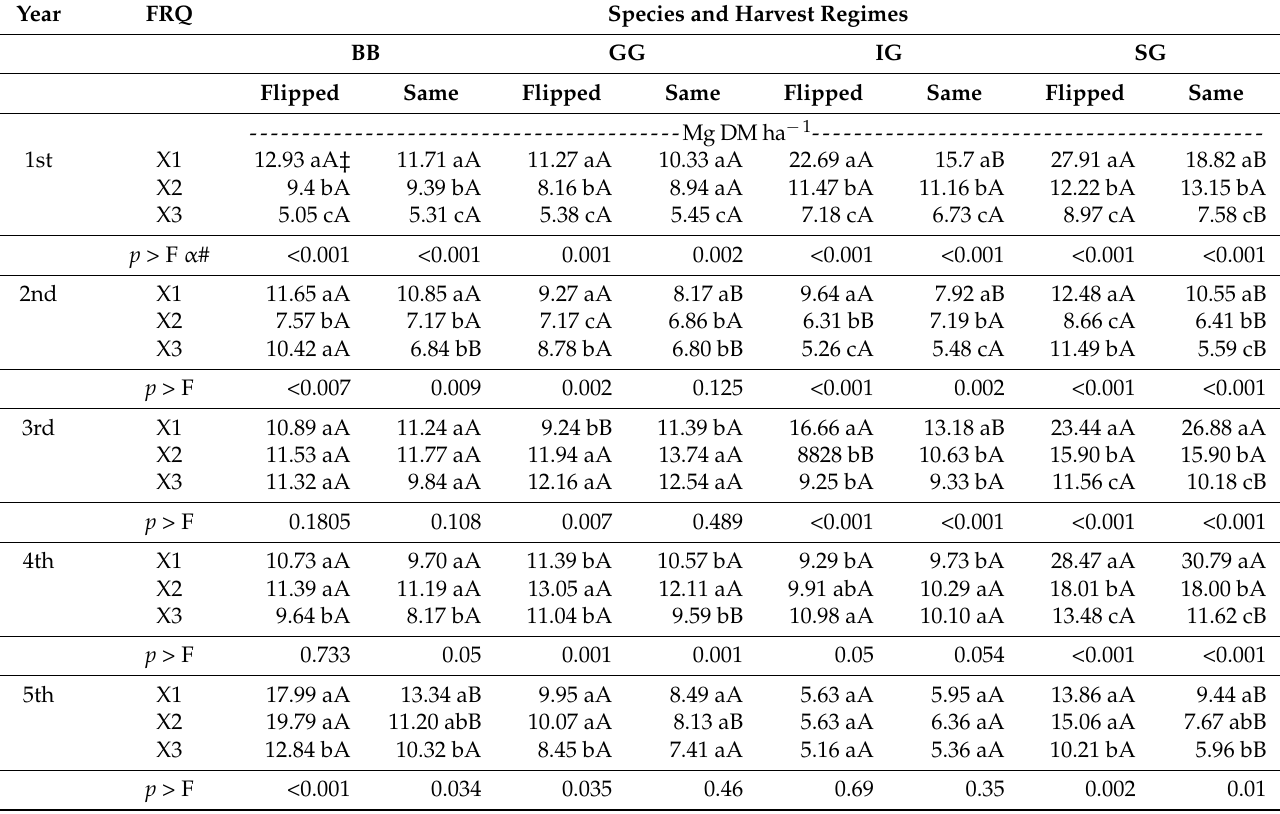
Table 4. Cumulative annual forage biomass of newly established NWSG † stands harvested